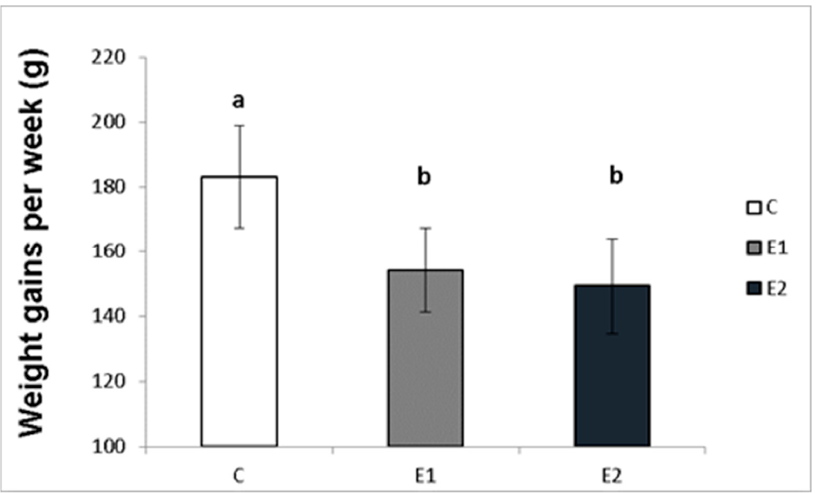
Figure 2. Average week weight gains (g) of male rabbits fed with green tea plant supplemented into complete feed mixture. C (without dietary green tea). E1–5 g green tea/100 kg normal food. E2–20 g green tea/100 kg normal food. Values and error bars express means ± SEM. a vs. b—difference is significant at p < 0.05.